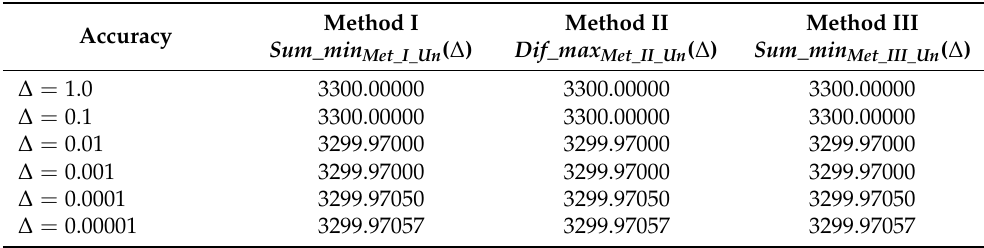
Table 18. Estimated lines lengths d ∆ of the reconstructed image for a given accuracy ∆ using the methods proposed by the authors.